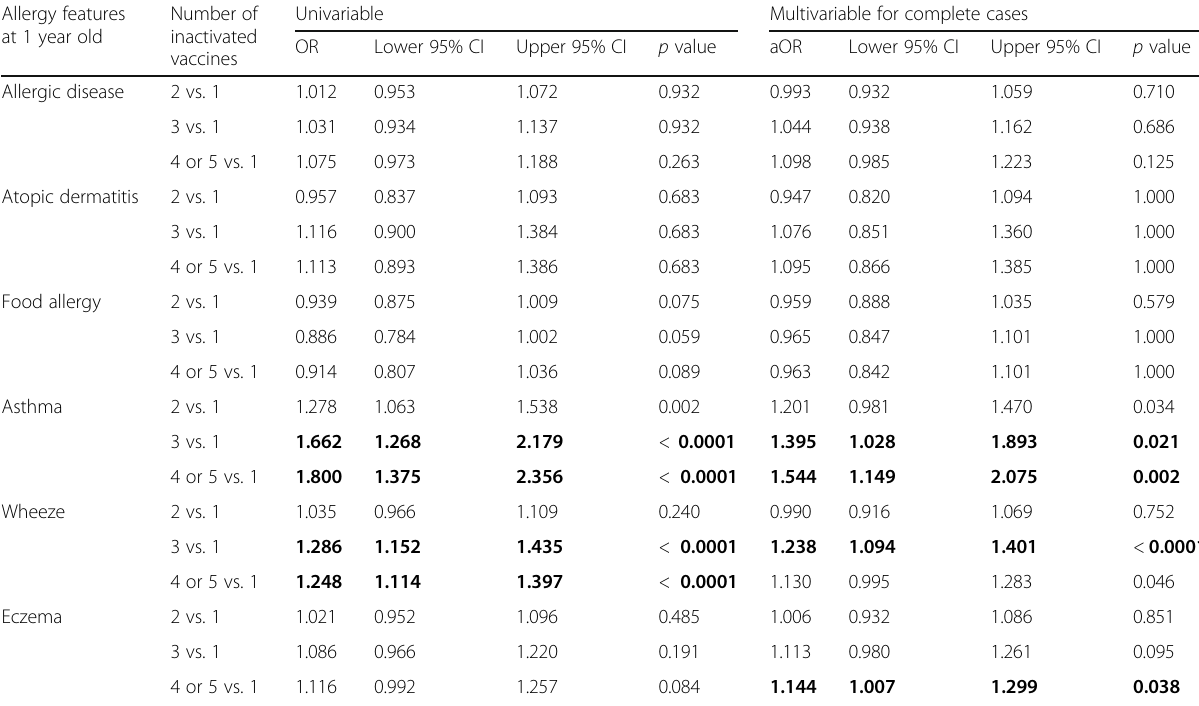
Table 3 Results of univariable and multivariable logistic regression for allergic features associated with number of initial inactivated vaccines received, in the JECS birth cohort